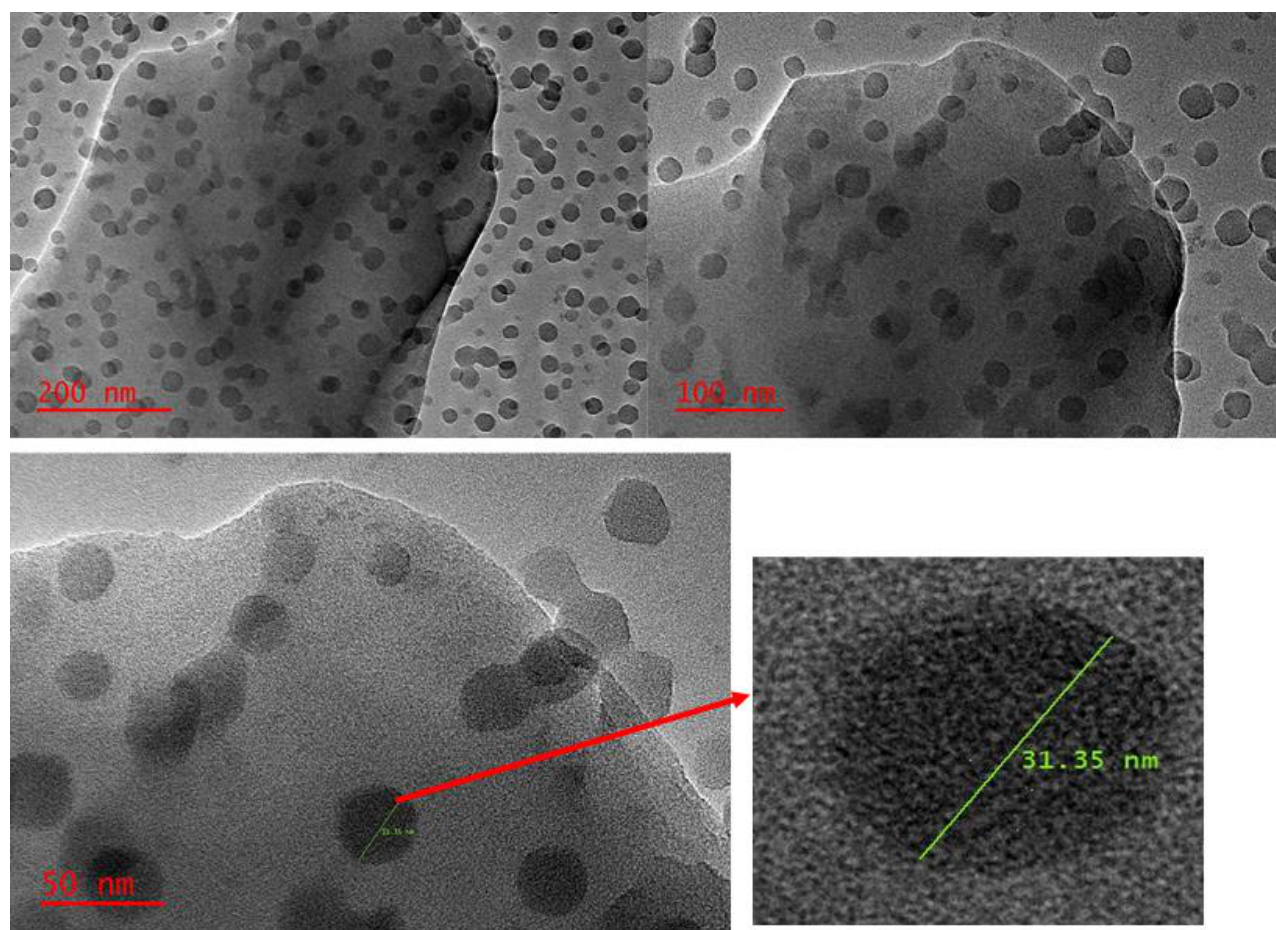
Figure 4. TEM image of ZIF-8@LDH nanocomposite at different scales.